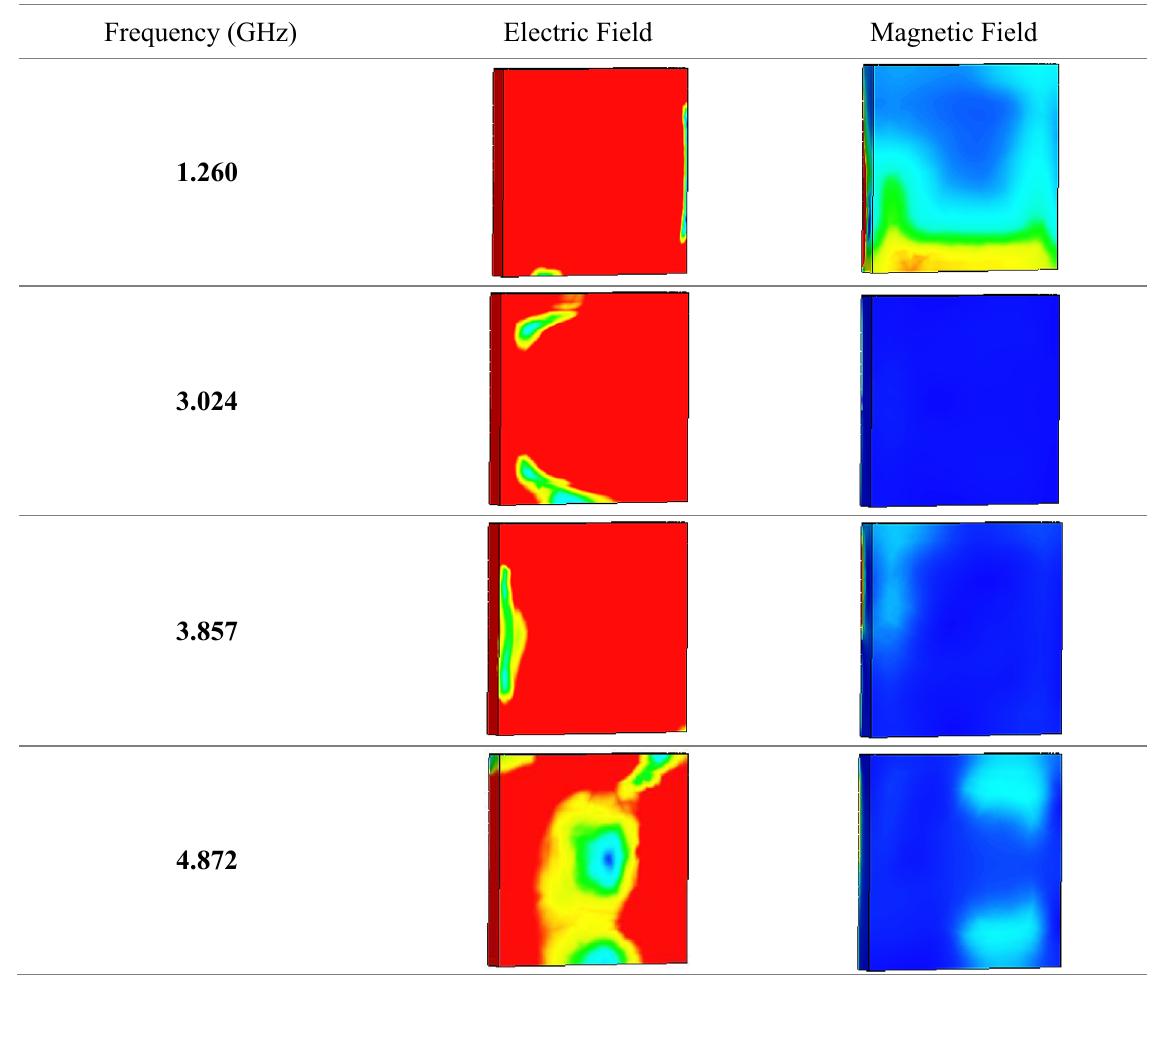
Table 4. Electric and magnetic field distributions of the unit cell SM design for back